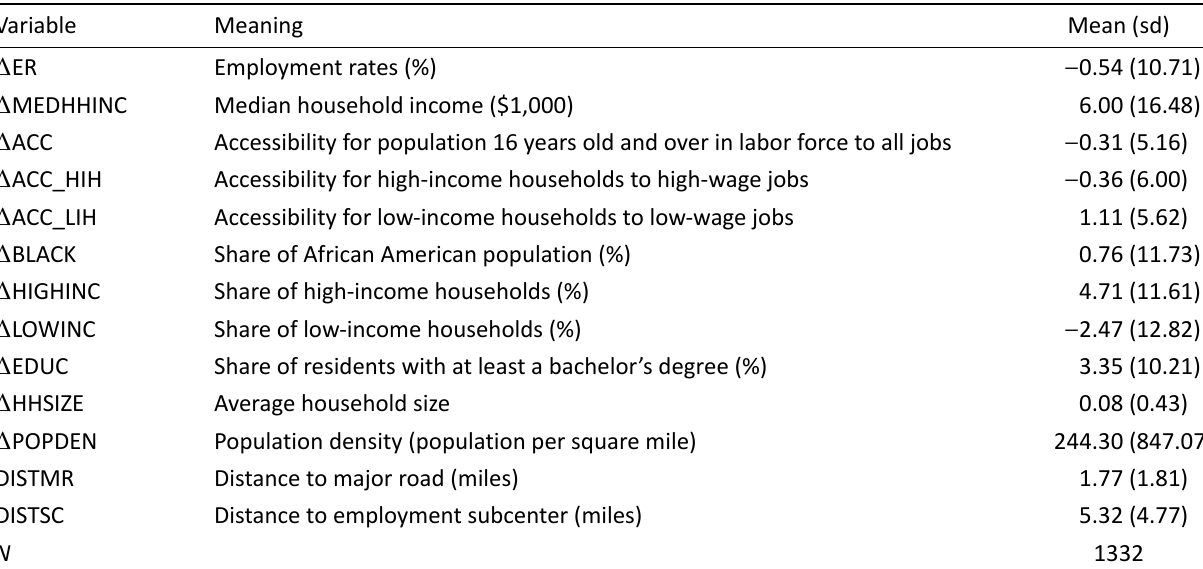
Table 1. Descriptive statistics for census block